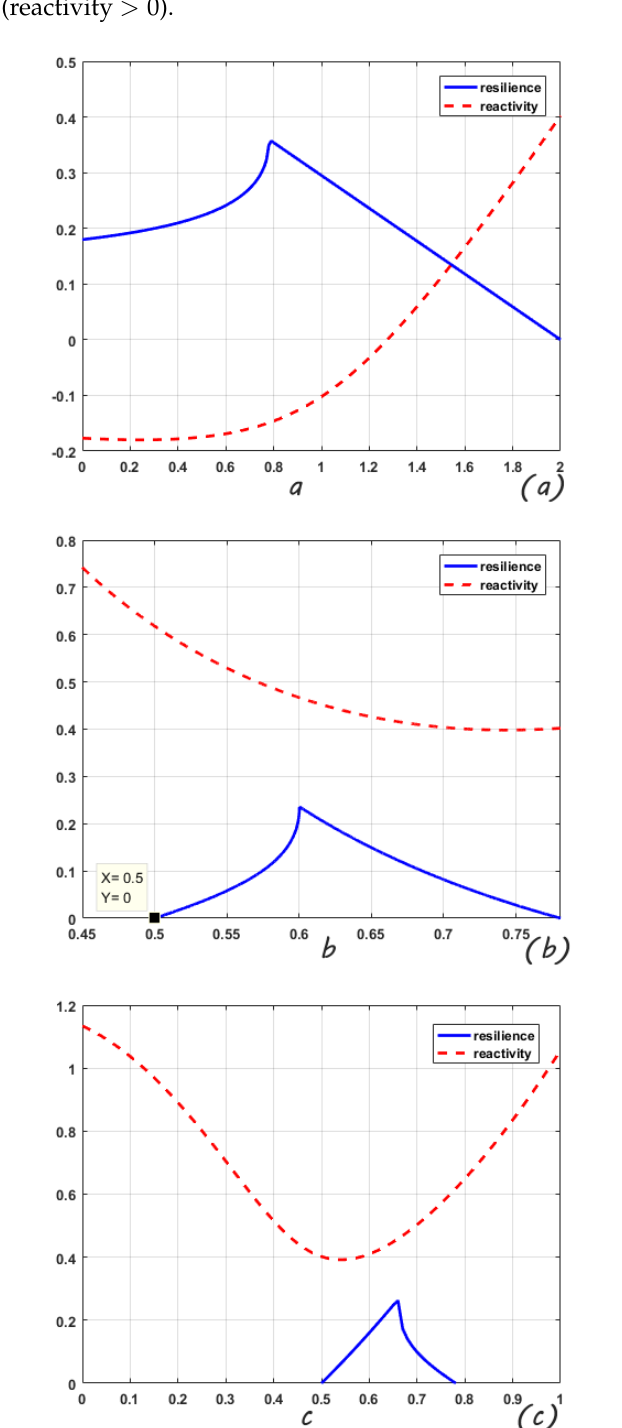
Figure 1. Resilience and reactivity (in the mean-square sense) of the positive equilibrium of (11), σ 1 = σ 2 = 0. In ( a ), b = 0.7808, c = 0.5. In ( b ), a = 2.0, c = 0.5. In ( c ), a = 2.0, b =